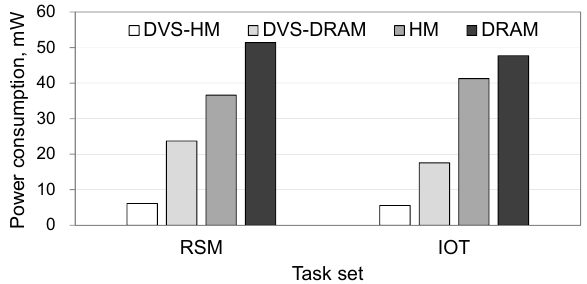
Figure 7. Total power consumption under realistic workloads.